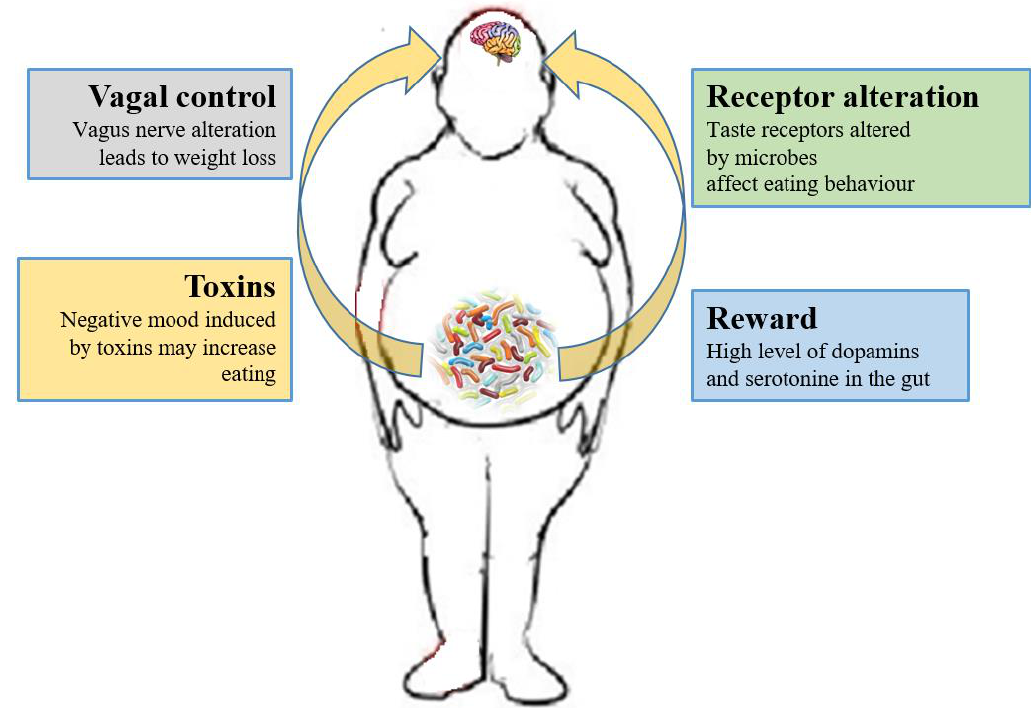
Figure 2. Relations between gut microbiota and eating behavior. The gut microbiota controls the eating behavior by several mechanisms, including changes to receptors such as taste receptors, regulation of reward pathways, production of toxins that alter mood, and deviating neurotransmission via the vagus